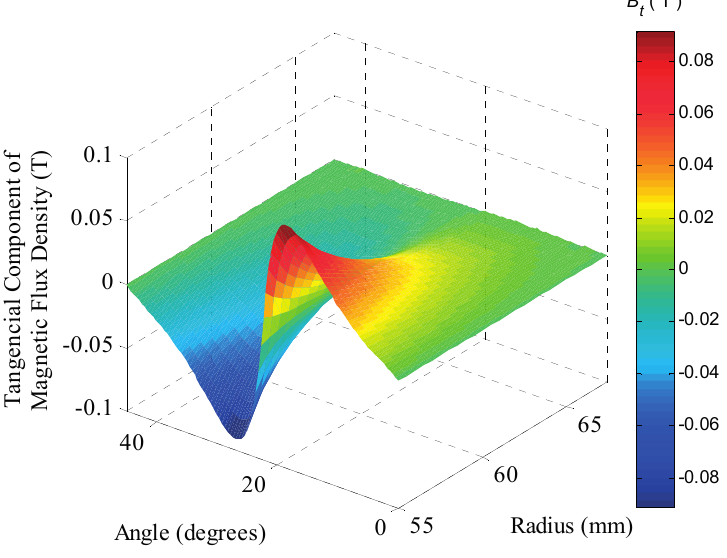
Figure 10. Tangential component of magnetic flux density in the region of the coils at an axial section located at τ /2 of the actuator with eight segments of parallel magnetization. m